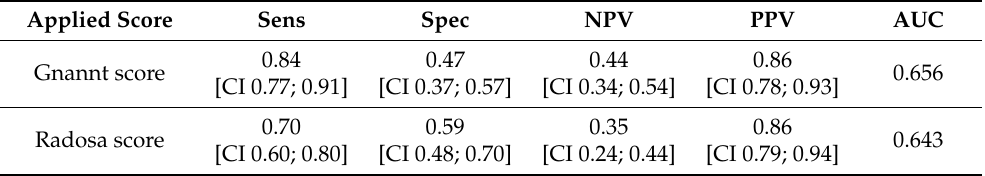
Table 5. Comparison of published scoring systems.